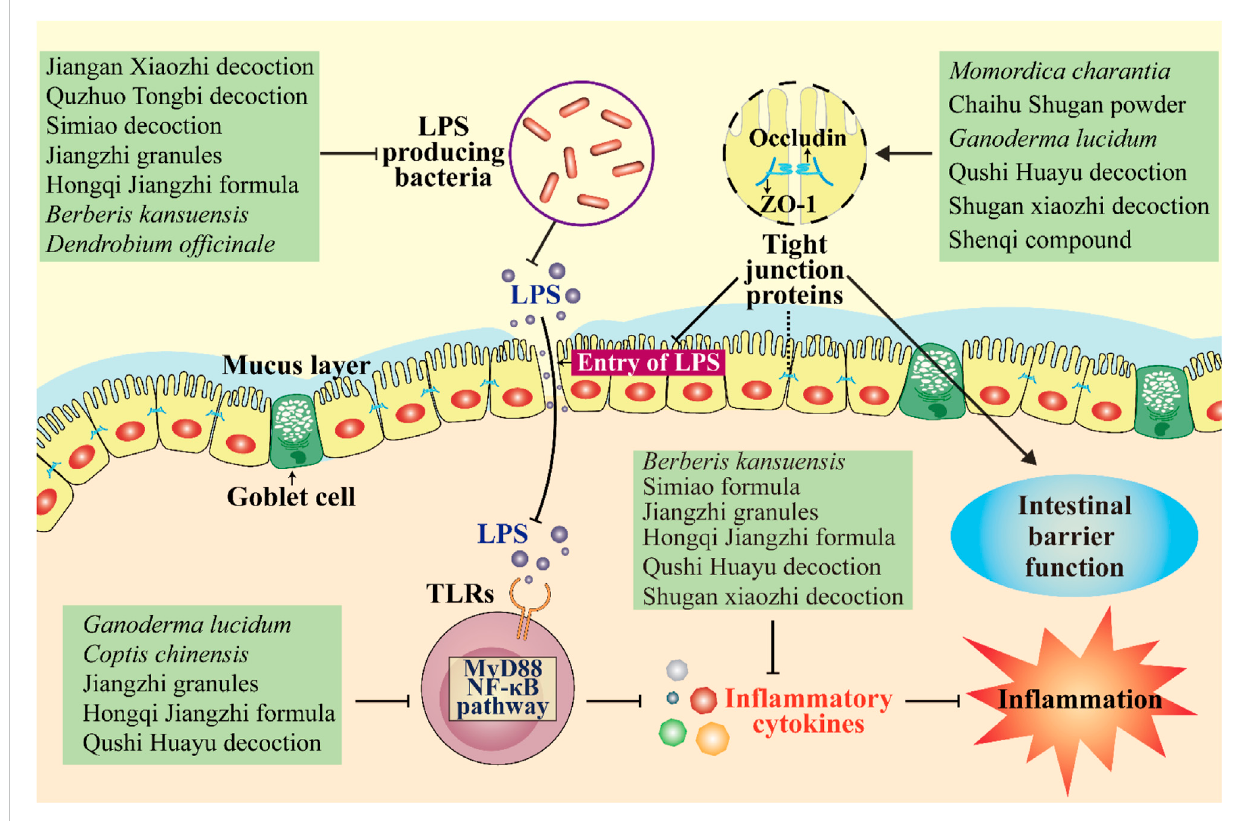
FIGURE 2 Herbal medicines regulate the intestinal barrier and in fl ammation. They protect the intestinal mucosal barrier by upregulating the expression of several tight junction proteins and thereby inhibiting LPS gut leakage. They can also inhibit LPS production by reducing the number of LPS-producing bacteria. Moreover, some herbal medicines improve in fl ammation by inhibiting the MyD88/NF- κ B pathway and reducing levels of in fl ammatory cytokines. ↓ , increase or activate; ⊥ , decrease or